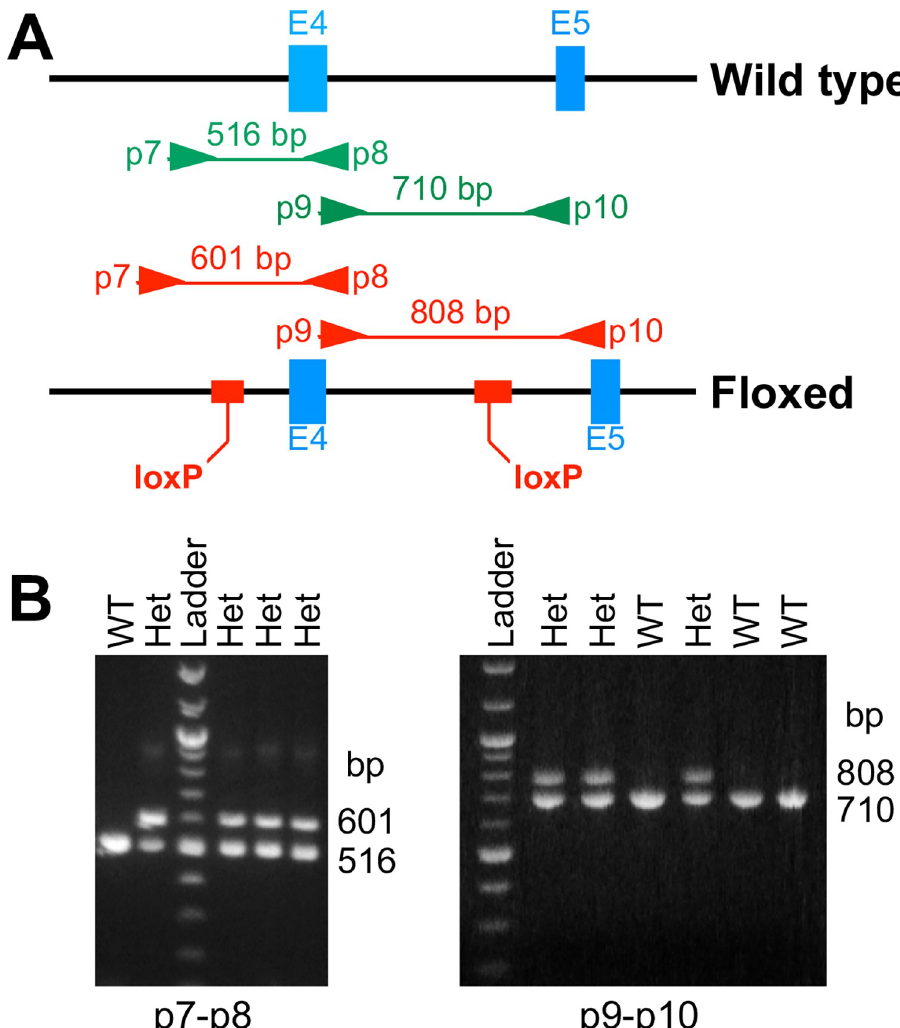
Fig 2. Two floxed Poldip2 genotyping methods. A: Genomic maps of mouse Poldip2 , around exons 4 (E4) and 5 (E5), showing the annealing sites of PCR primer pairs p7-p8 and p9-p10, surrounding 5’ and 3’ loxP sites, respectively, as well as corresponding amplicons from wild type (green, top) and floxed (red, bottom) alleles. The positions of DNA inserts that include loxP sites are shown in the floxed allele (bottom, red boxes). B: Representative agarose gels, following PCR of mouse genomic DNA samples, using primer pairs p7-p8 (left) or p9-p10 (right). Genotypes of individual mice are indicated at the top: wild type (WT) or heterozygous (Het). Steps in the DNA ladder are multiples of 100 bp, with higher intensities at 500 and 1,000